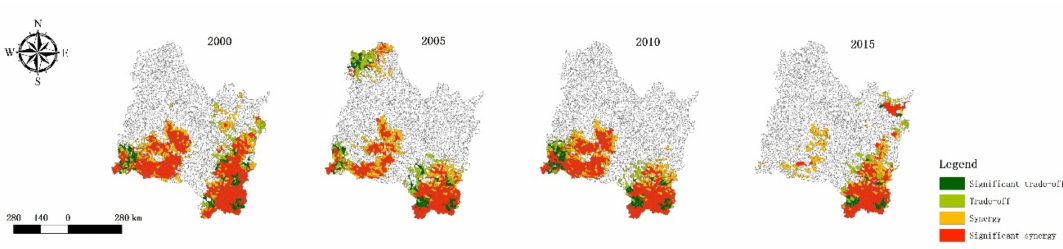
Figure 14. The synergy/trade-off relationship between soil conservation and carbon sequestration. The synergy/trade-off relationship between biodiversity and carbon sequestration at the spatial scale from 2000 to 2015 is shown in Figure 15 and Table S1. In 2000, the biodiversity and carbon sequestration showed a significant synergistic relationship in the Songnen Plain. Meanwhile, there is a very significant synergy in the core area of Changbai Mountain. When the amount of carbon sequestration and biodiversity are maintained at a high/low level, the two show a significant synergy. At the western edge of Changbai Mountain, the biodiversity and carbon sequestration show a trade-off relationship. In 2005, the synergistic area of the Songnen Plain and Changbai Mountain was reduced. Part of the synergy/trade-off area appears in the northwest of the Great Khingan Mountains, and this area mainly shows a trade-off relationship. The synergy/trade-off relationship between biodiversity and carbon sequestration in 2010 is similar to that in 2000, but the synergistic area of Changbai Mountain has decreased. Compared with previous years, the synergy/trade-off relationship in 2015 had undergone major changes. The synergistic area of the Songnen Plain has been drastically reduced. Meanwhile, a large number of trade-off areas have been generated on the western side of Changbai Mountain, and the EUs showing a trade-off relationship have rapidly increased.